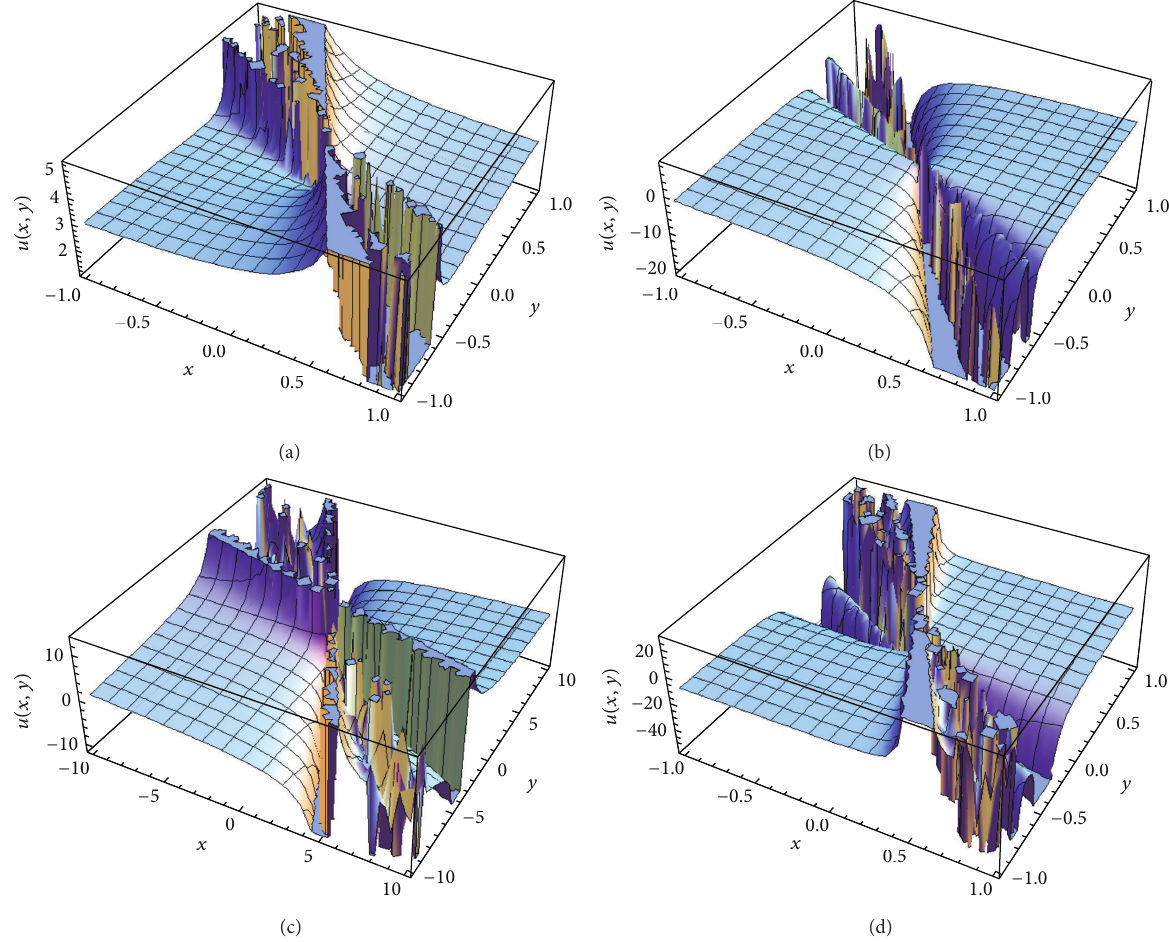
Figure 3: Travelling waves solutions (29) and (30) with various different shapes are plotted: multiple travelling wave solutions (a and b). Travelling waves solutions (33) and (34) with various different shapes are plotted: multiple travelling wave solutions (c and